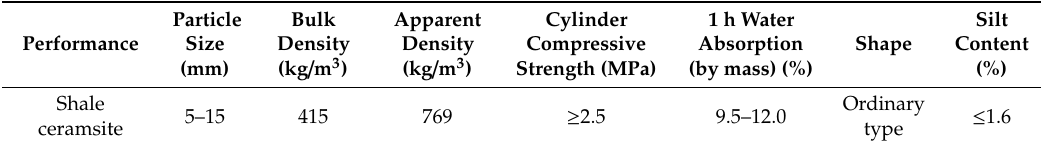
Table 1. Physical properties of shale ceramsite.